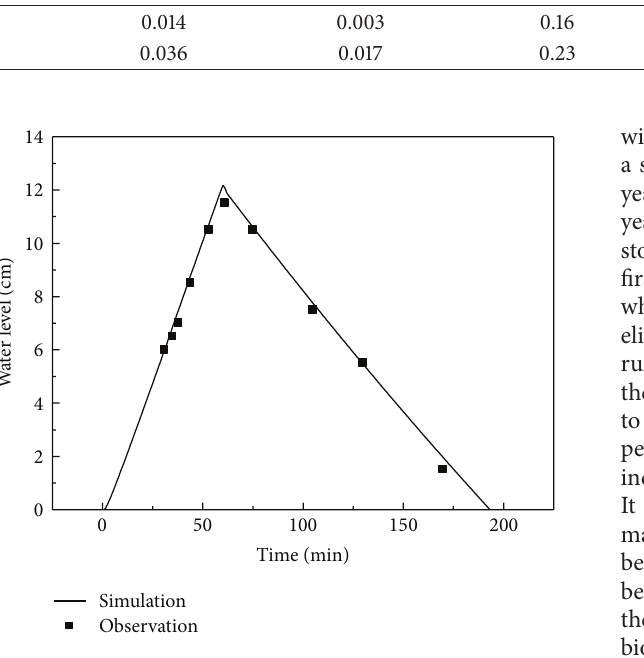
Figure4:Observedandsimulatedwaterlevelintheartificialrainfall for validation in Cell